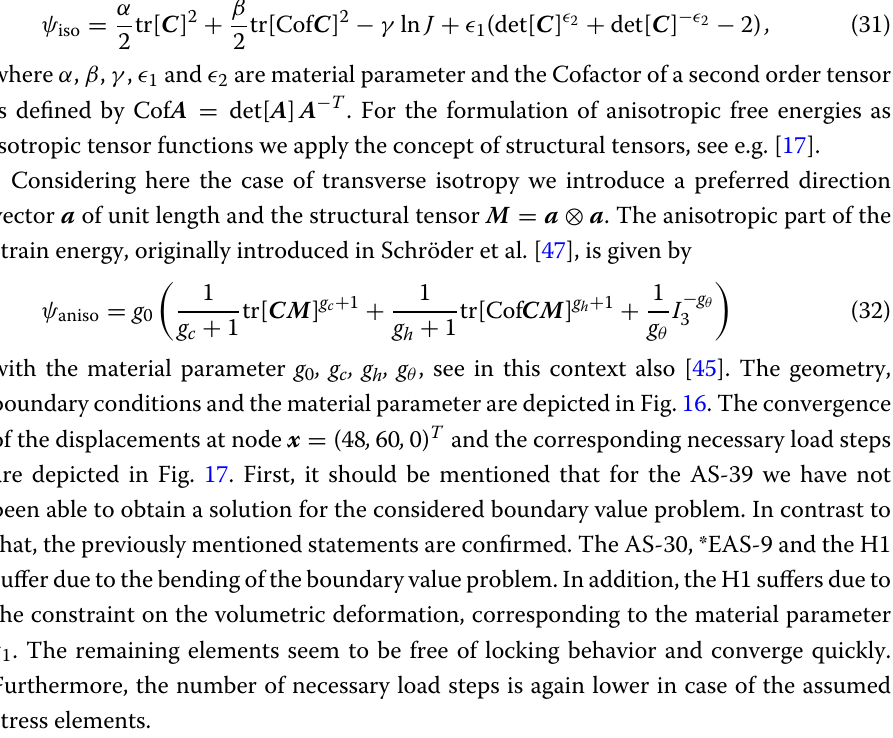
The isotropic part is represented by the following strain energy of Mooney-Rivlin